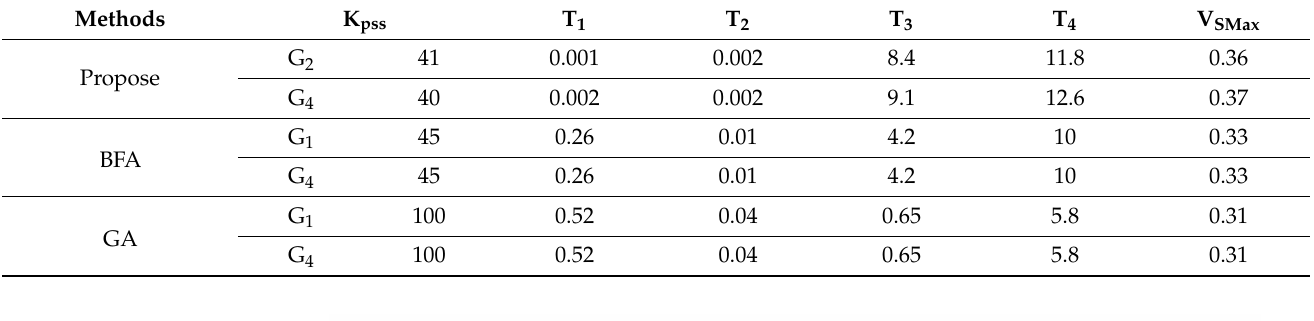
Table 6. The optimal parameters obtained for locating the PSS of the four-machine power system.